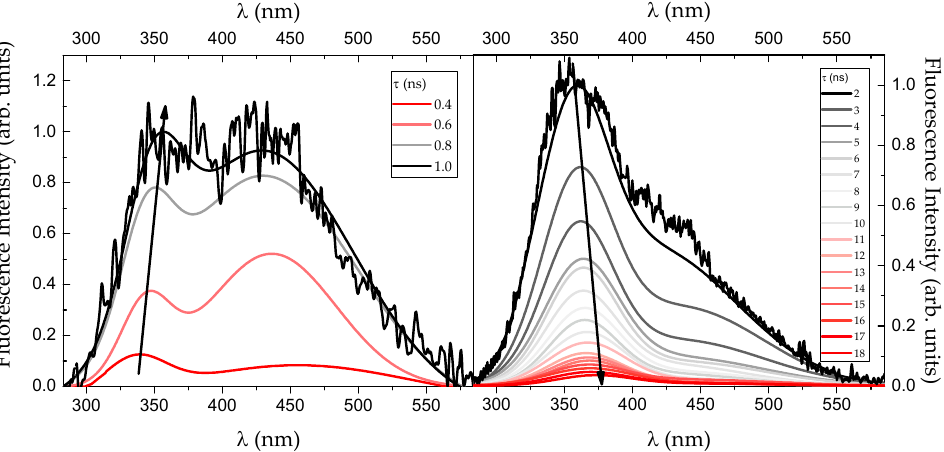
Figure 4. Time-resolved emission spectra ( λ exc. = 300 nm) of II in phosphate buffer solution with BSA (c BSA = 10 − 6 M) at various times after excitation.